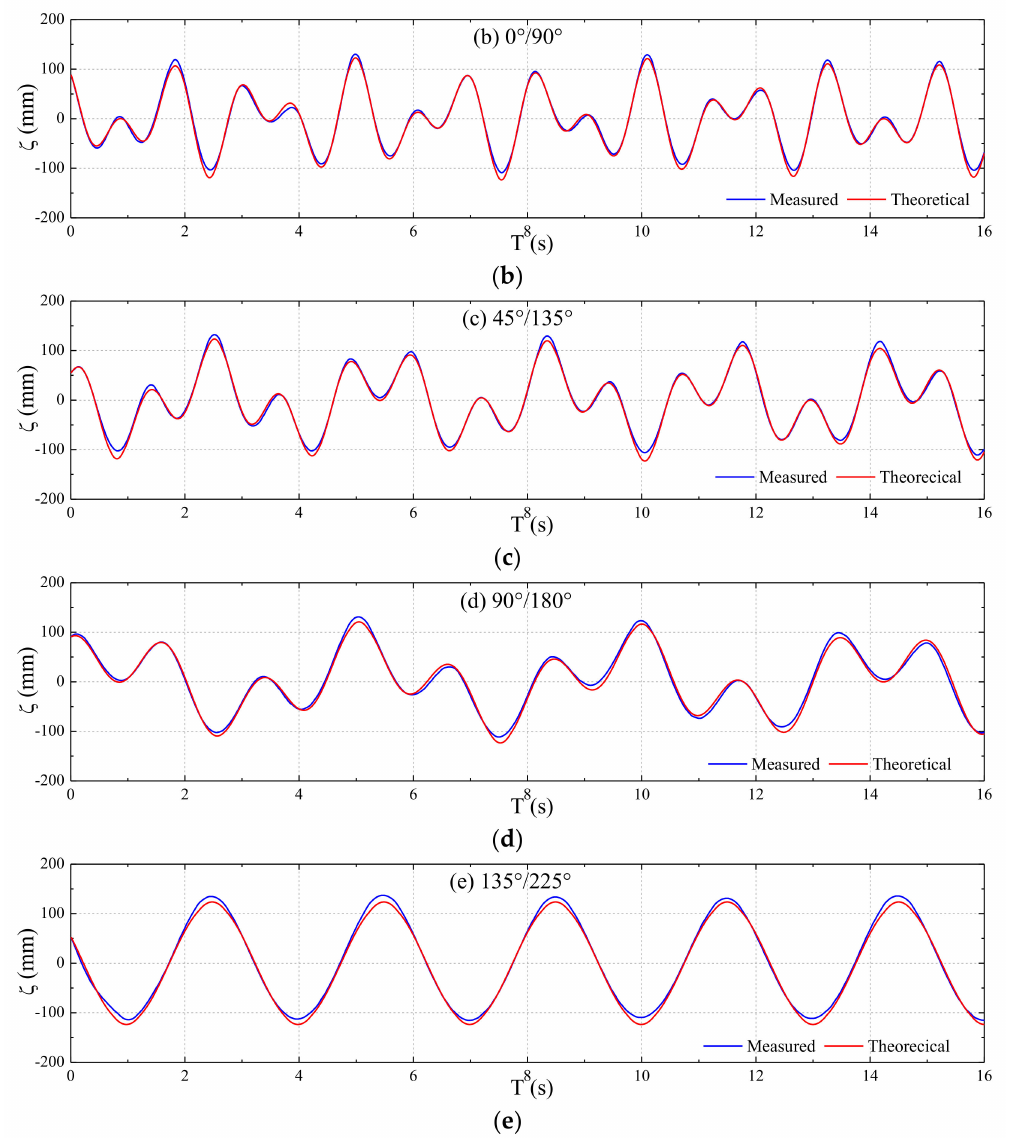
Figure 11. Surface elevation of ship encounter wave: ( a ) 45 ◦ / 315 ◦ (Case 4); ( b ) 0 ◦ / 90 ◦ (Case 9); ( c ) 45 ◦ / 135 ◦ (Case 10); ( d ) 90 ◦ / 180 ◦ (Case 11); ( e ) 135 ◦ / 225 ◦ (Case